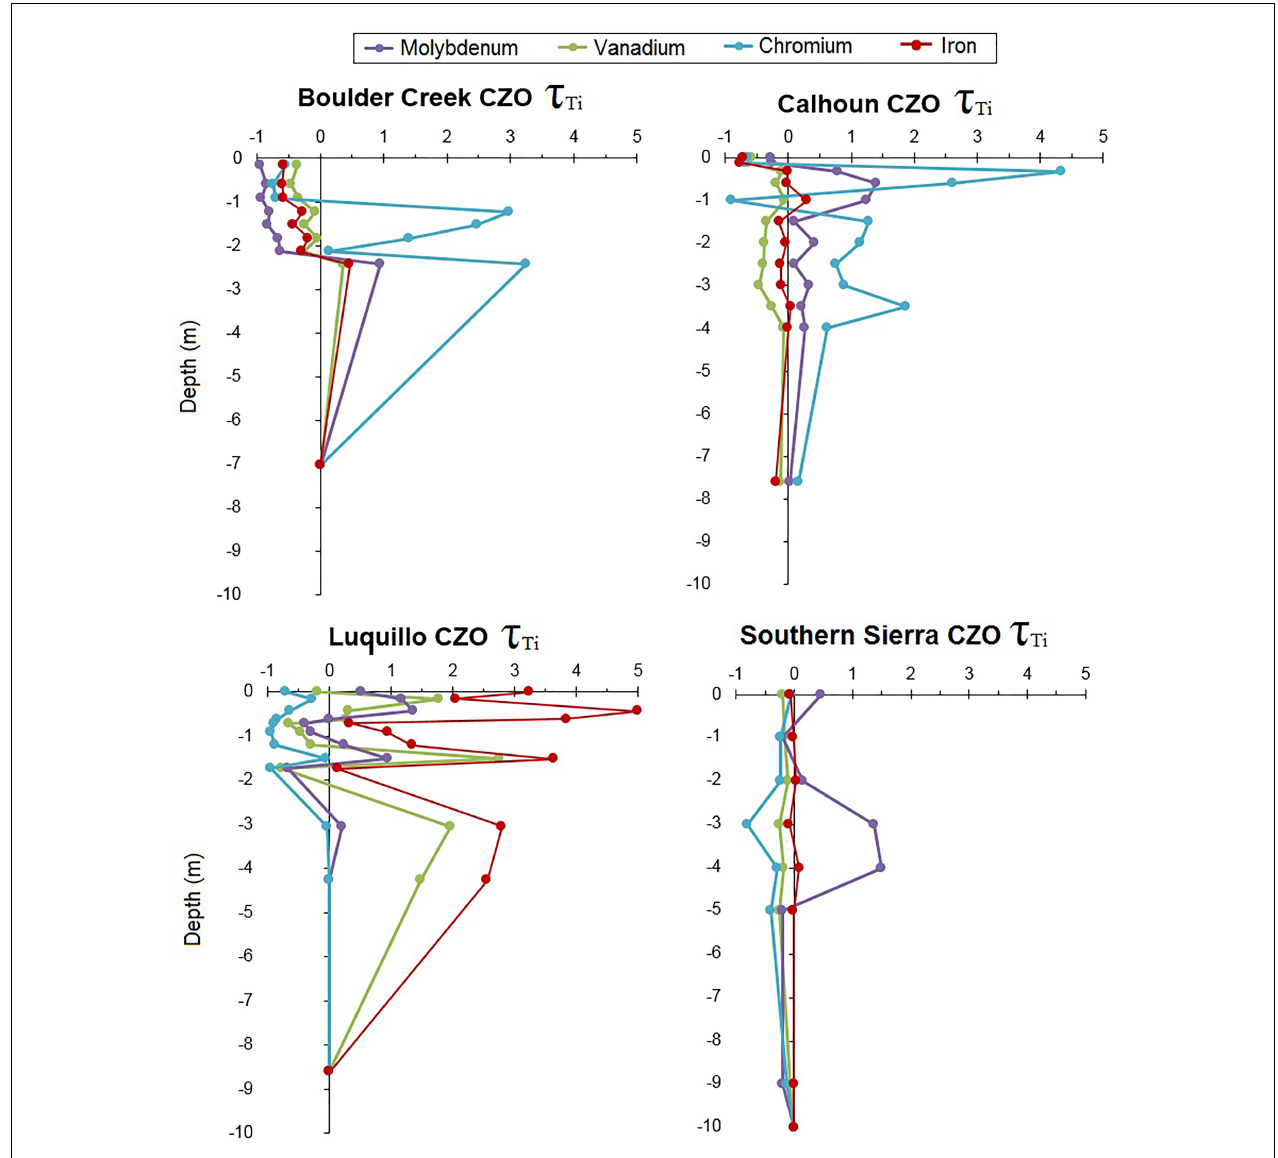
FIGURE 4 | Mass transfer coefficients ( τ ) for Mo, V, Cr, and Fe for regolith profiles at each CZO, using Ti as the indexing